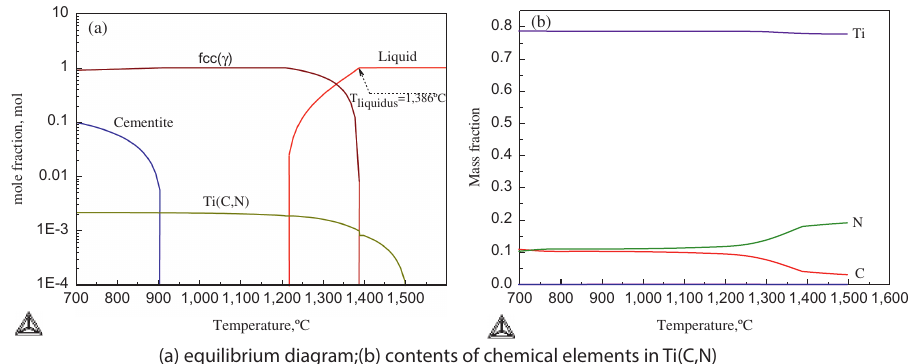
Figure 6: Phase transformation behavior and equilibrium phases in steel 2 predicted by